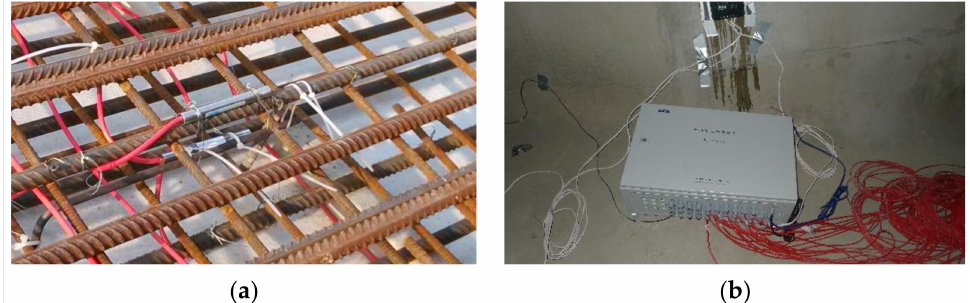
Figure 3. Burial site of temperature sensor: ( a ) binding condition of temperature sensor; ( b ) data acquisition instrument in box girder.